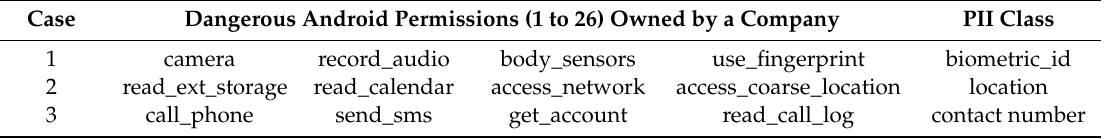
Table 6. Dangerous Android permission versus personally identifiable information (PII)